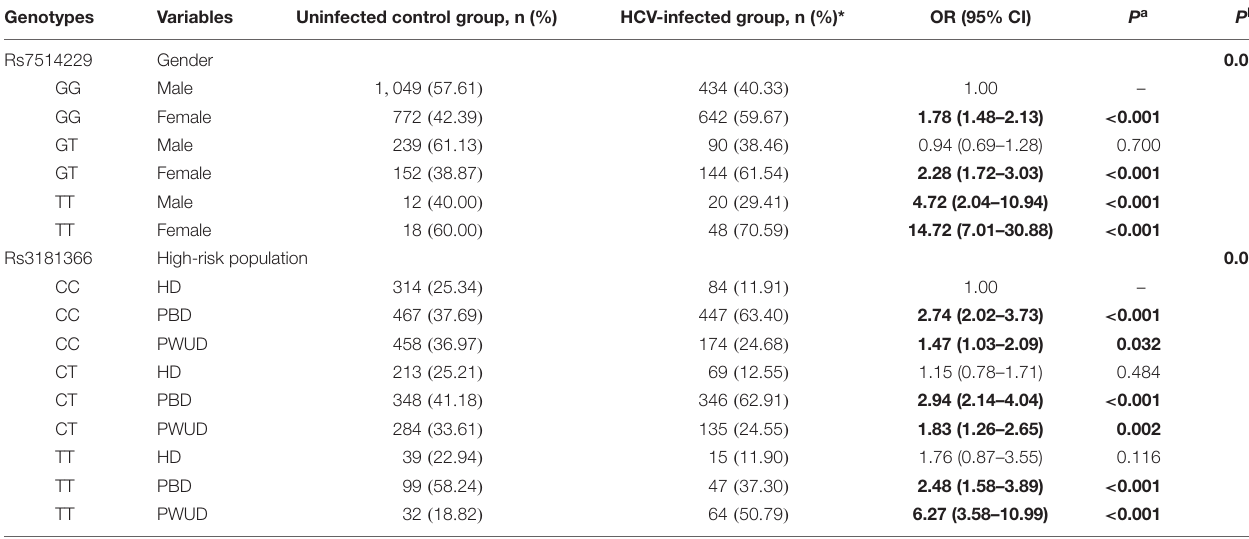
TABLE 5 | Interaction analysis between two SNPs and other factors on the risk of HCV infection. Genotypes